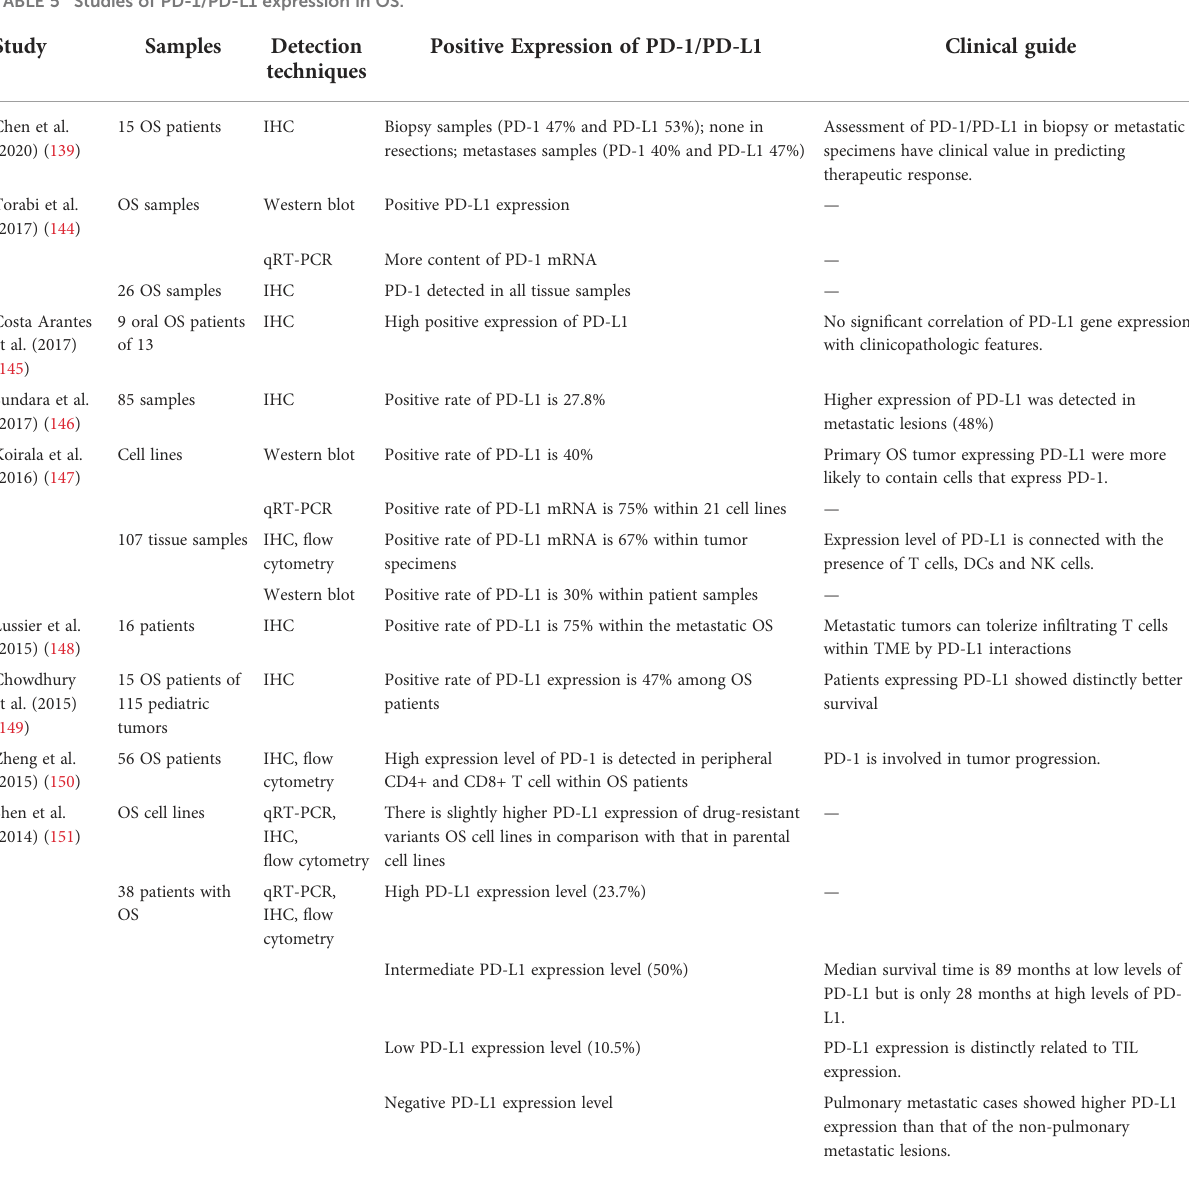
TABLE 5 Studies of PD-1/PD-L1 expression in OS.